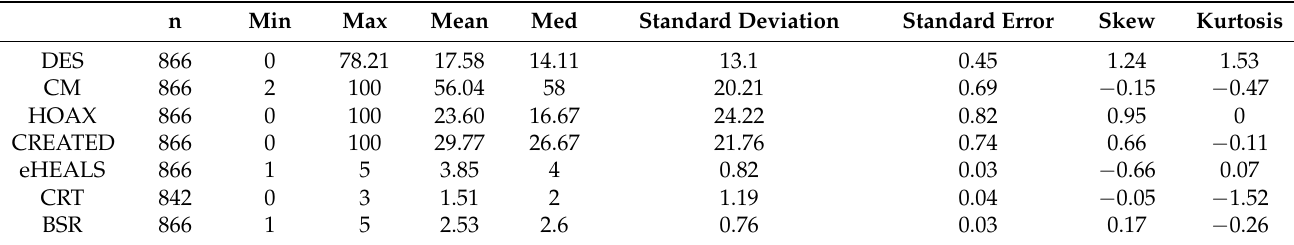
Table 1. Descriptive statistics.